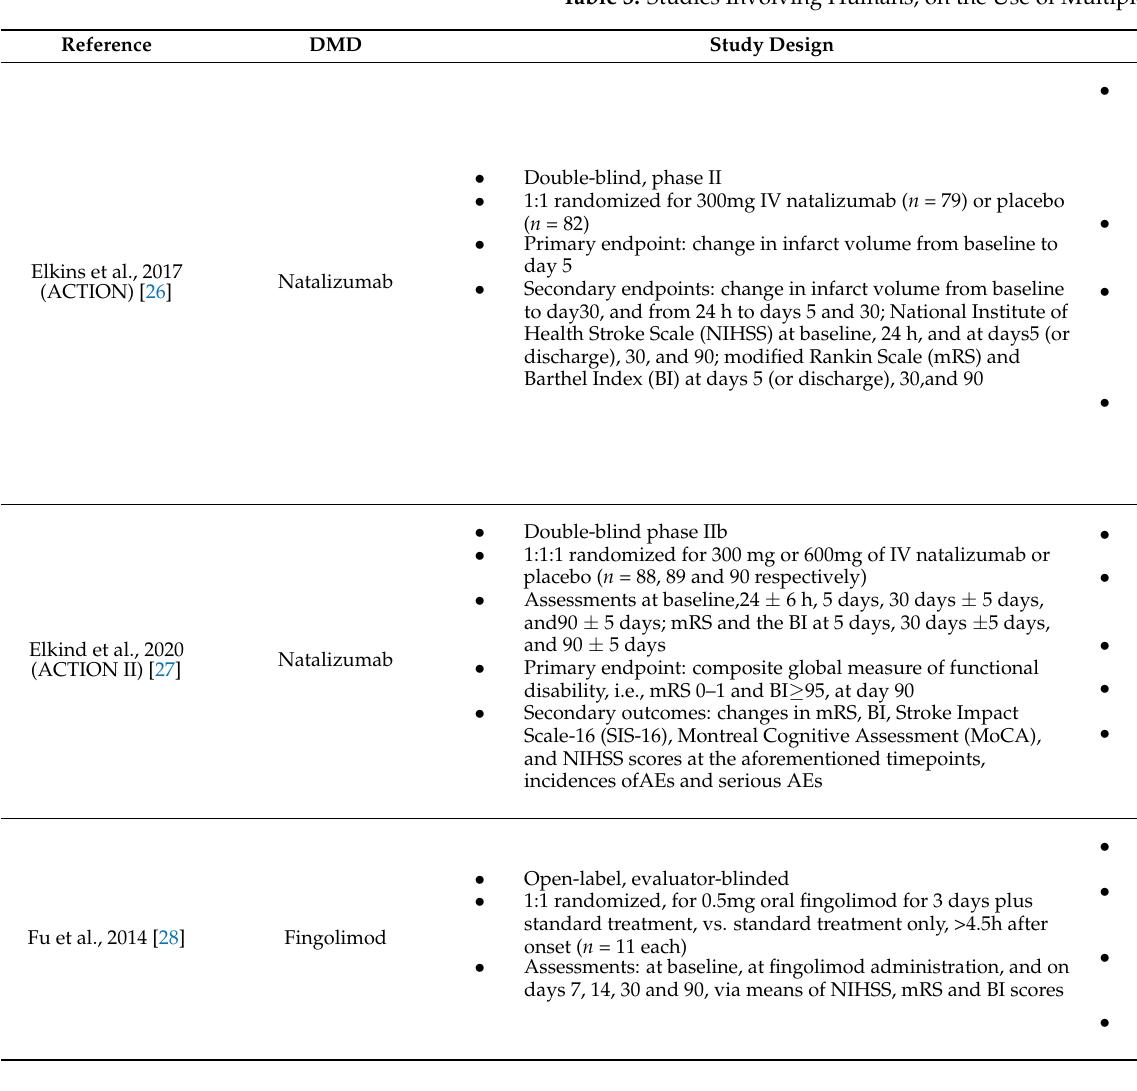
Table 3. Studies Involving Humans, on the Use of Multiple Sclerosis DMDs in